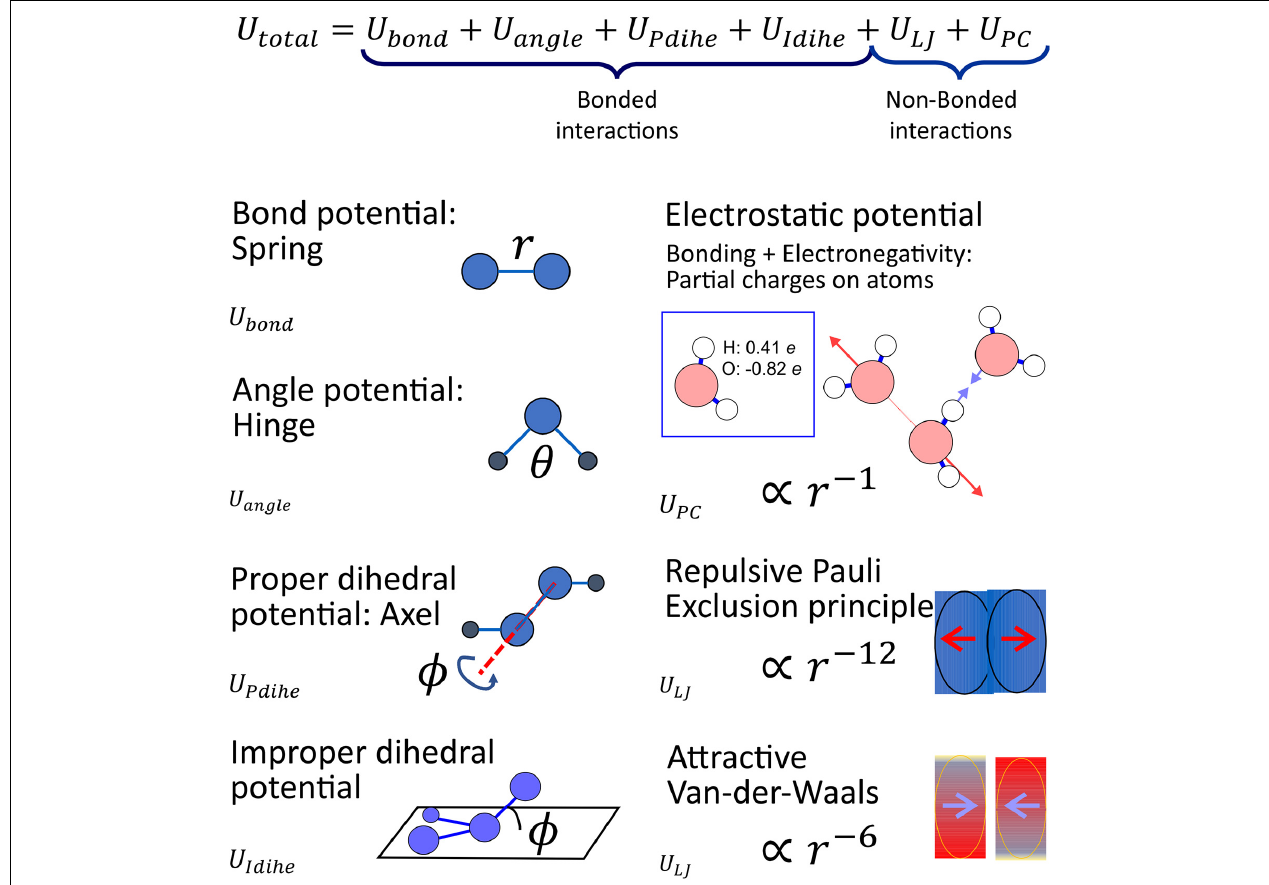
FIGURE 1 | The set of interactions that are the molecular mechanics paradigm that defines the forces that drive the motion of atoms in a molecular dynamics simulation with all atom resolution. The bond, angle and dihedral potentials are the intramolecular interactions that define molecule structure and the interactions between covalently bound atoms. Each atom has a partial charge that interacts with all other atoms through electrostatic forces to model electronegativity and H-bonding behavior; short range attractive and repulsive forces due to the Van-der-Waals and Pauli Exclusion Principle, respectively, are modeled through the Lennard-Jones